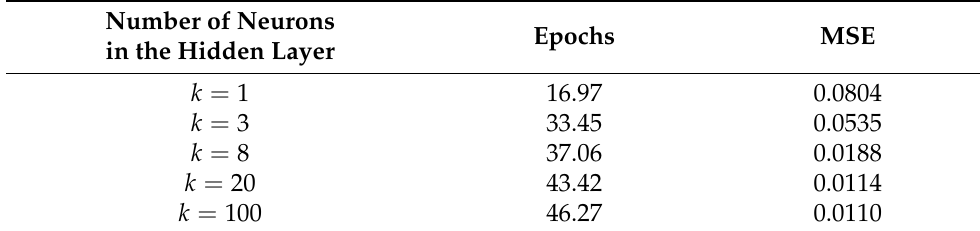
Table 2. Parameters of the network.